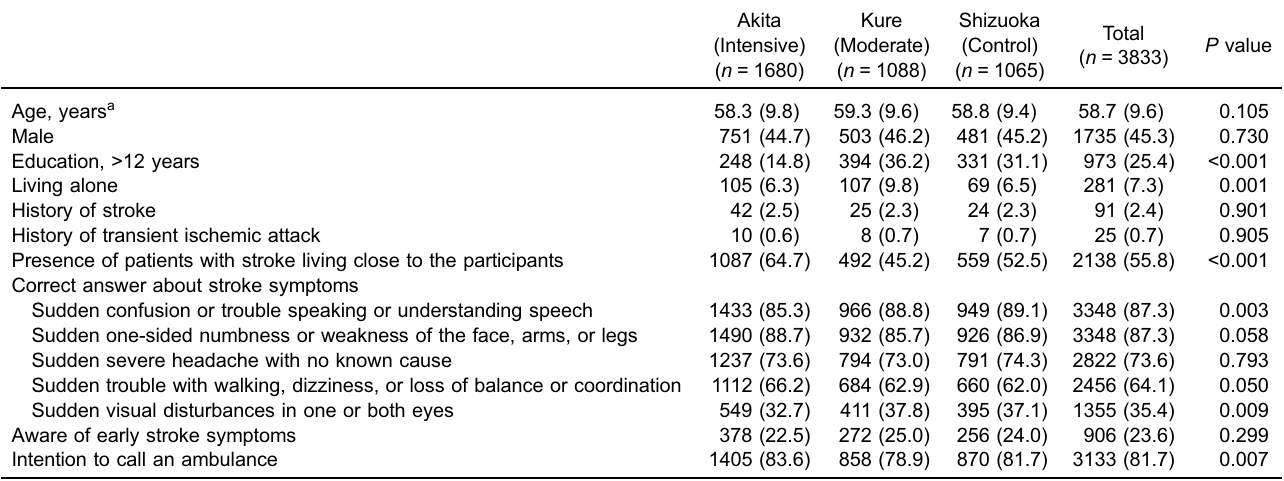
Table 1. Demographics, knowledge of early stroke symptoms and intention to call an ambulance at stroke in the pre-intervention